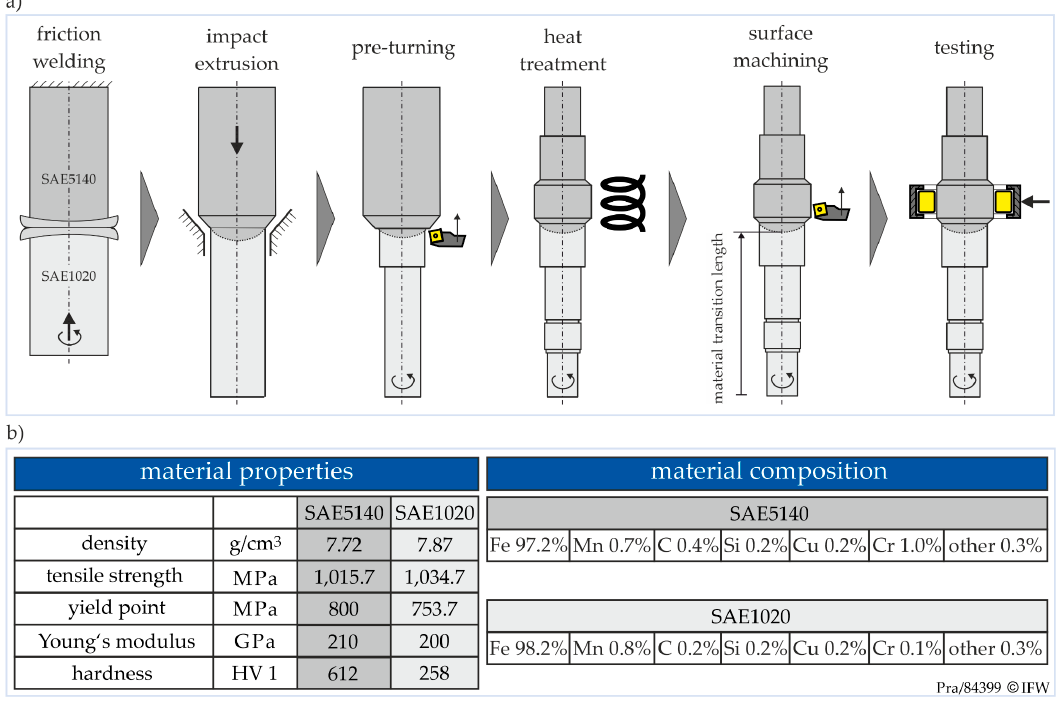
Figure 1. ( a ) Process chain for the production of hybrid shafts, and ( b ) material properties and composition.